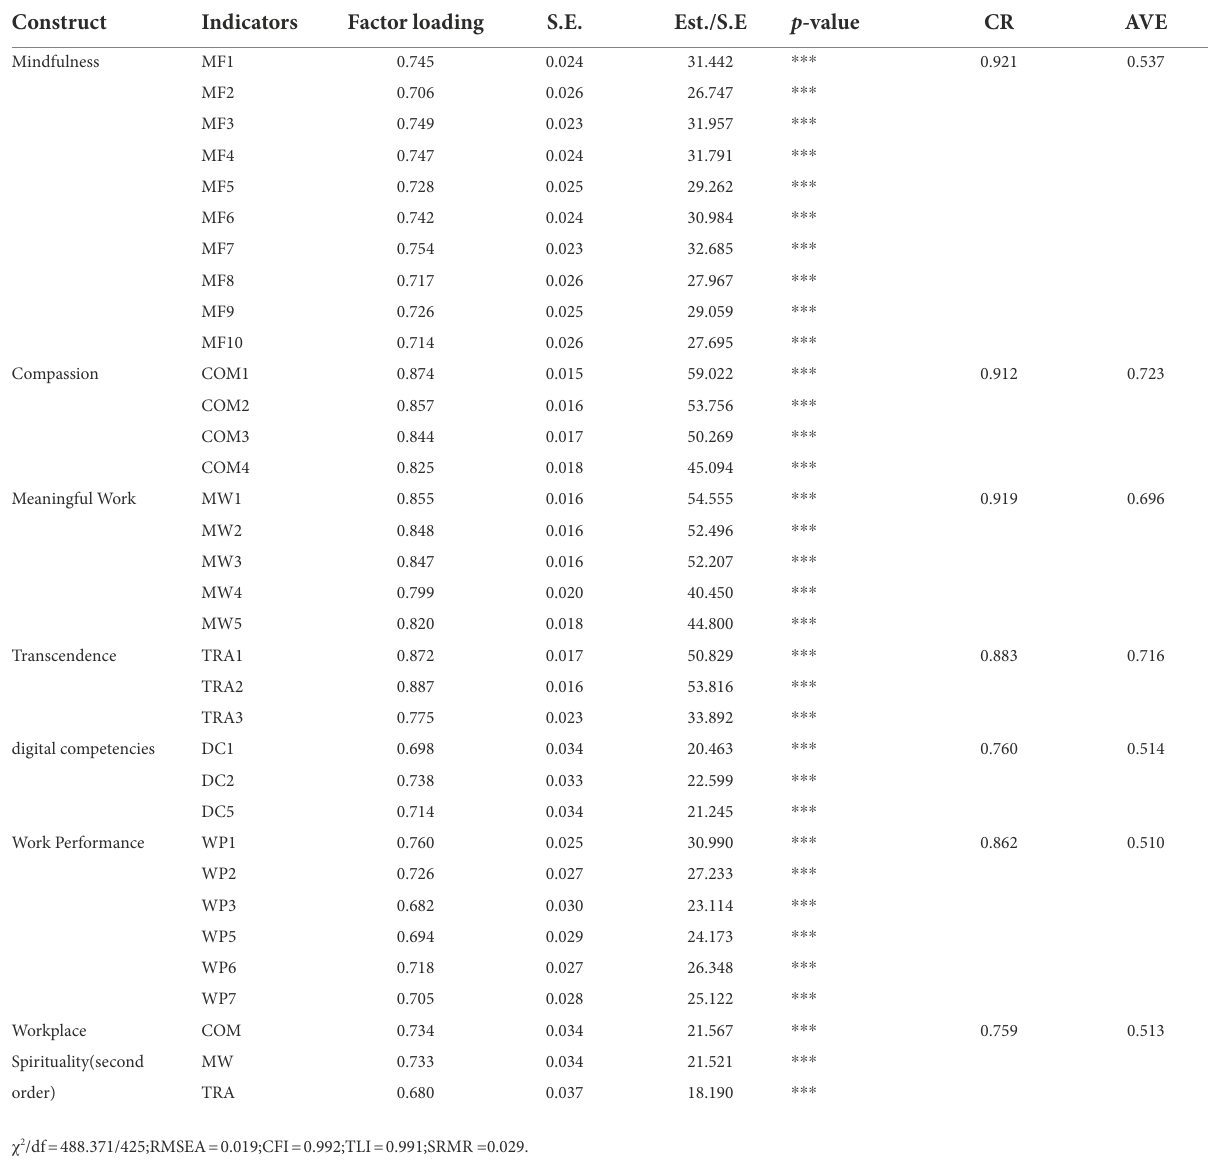
TABLE 3 Results of the measurement